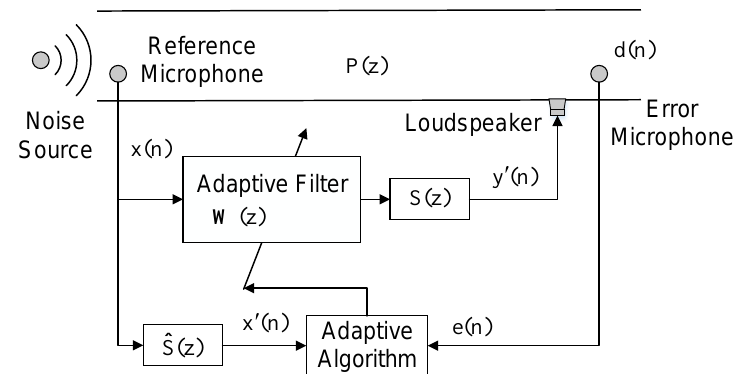
Figure 1. The feed-forward ANC detail